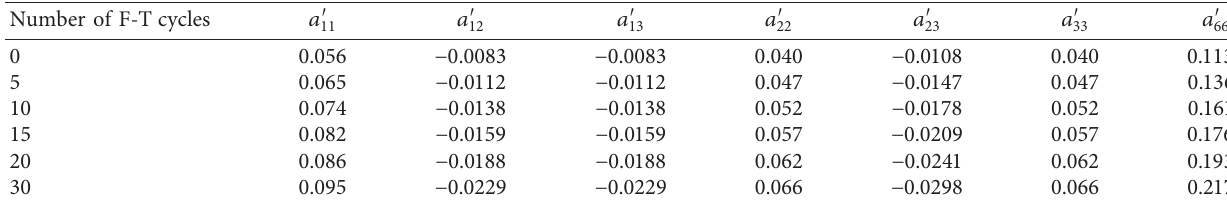
ij , for different numbers of F-T cycles.